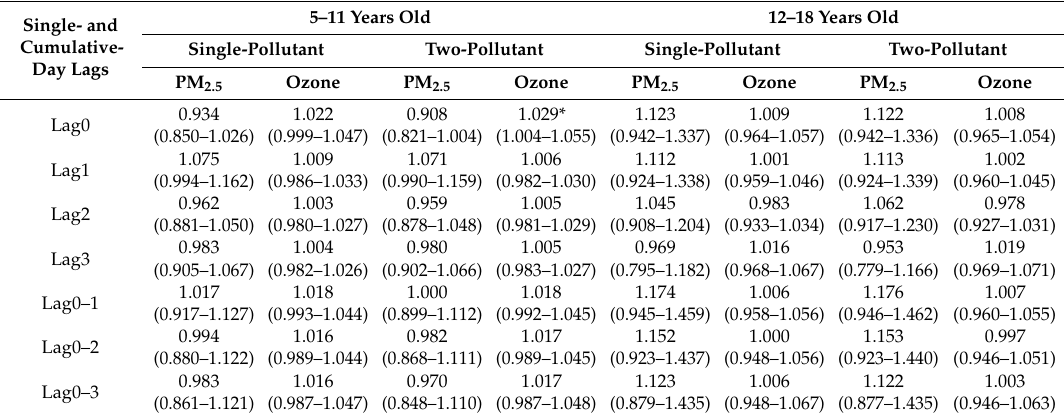
Figure 1. Odds ratio (OR) and 95% confidence interval (CI) of PM 2.5 and ozone with hospital readmissions for children with asthma in the single- and two-pollutant models (* p < 0.05). Table 4. Results of the conditional logistic regression models stratified by age.